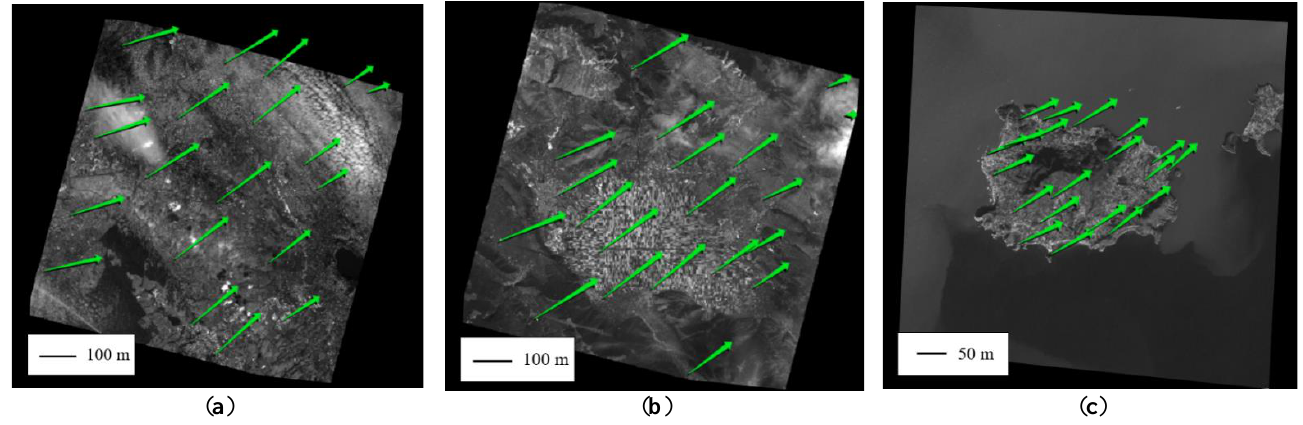
Figure 9. The planimetric errors — RPC model with no refinements applied, test field of Rome ( a ), Fucino ( b ) and Ischia ( c ).